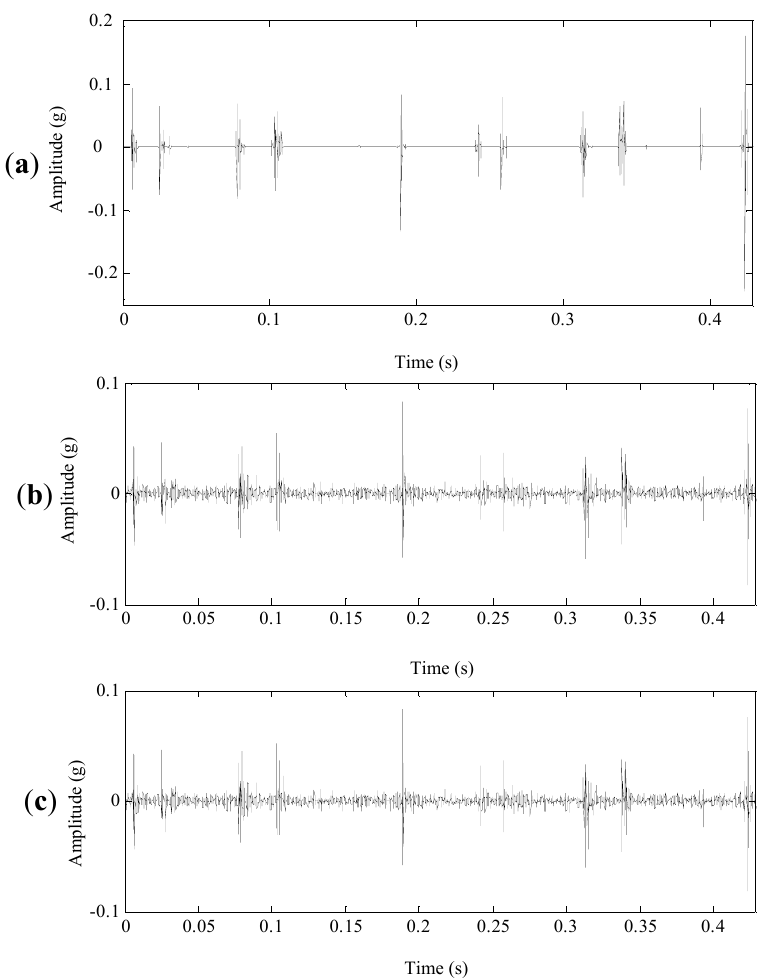
Figure 16. The denoising results of the planetary gearbox signal. ( a ) Customized multiwavelet and NC. ( b ) GHM multiwavelet + INC. ( c ) GHM multiwavelet +